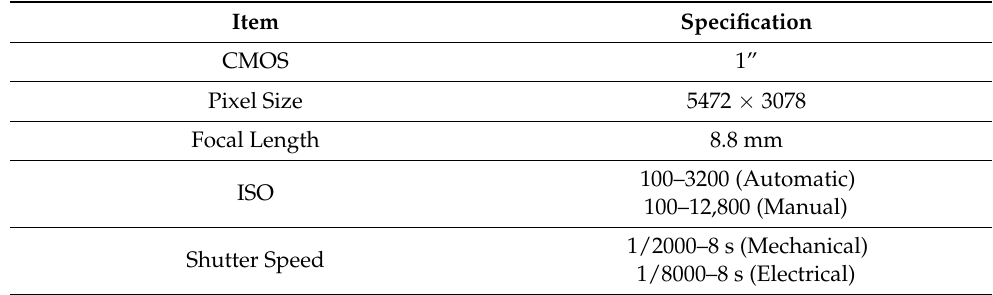
Table 4. Specification of the digital camera used in the test from [38].